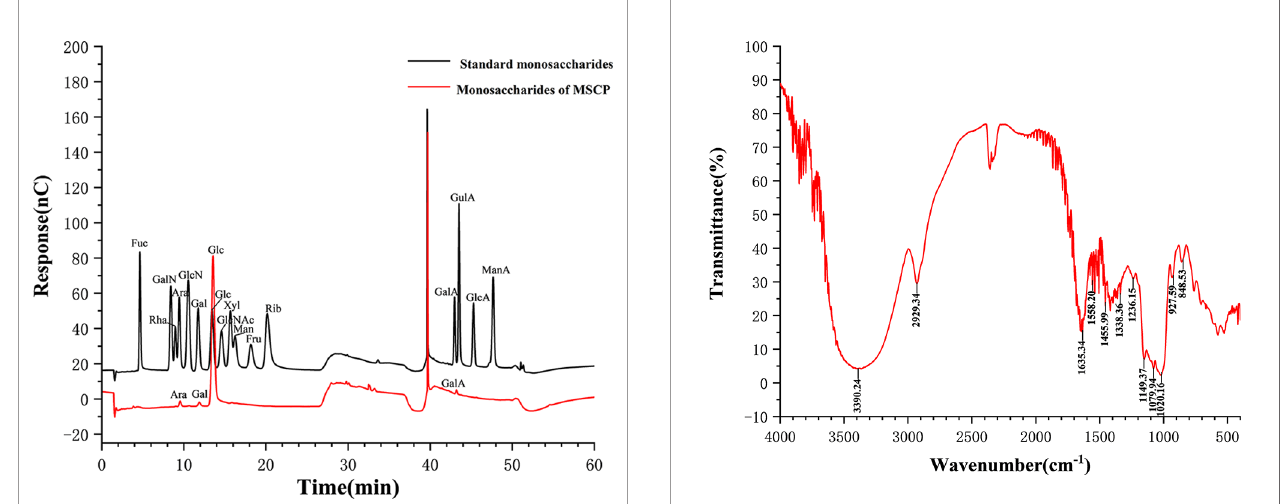
FIGURE 2 | Ion chromatogram data of monosaccharide composition.